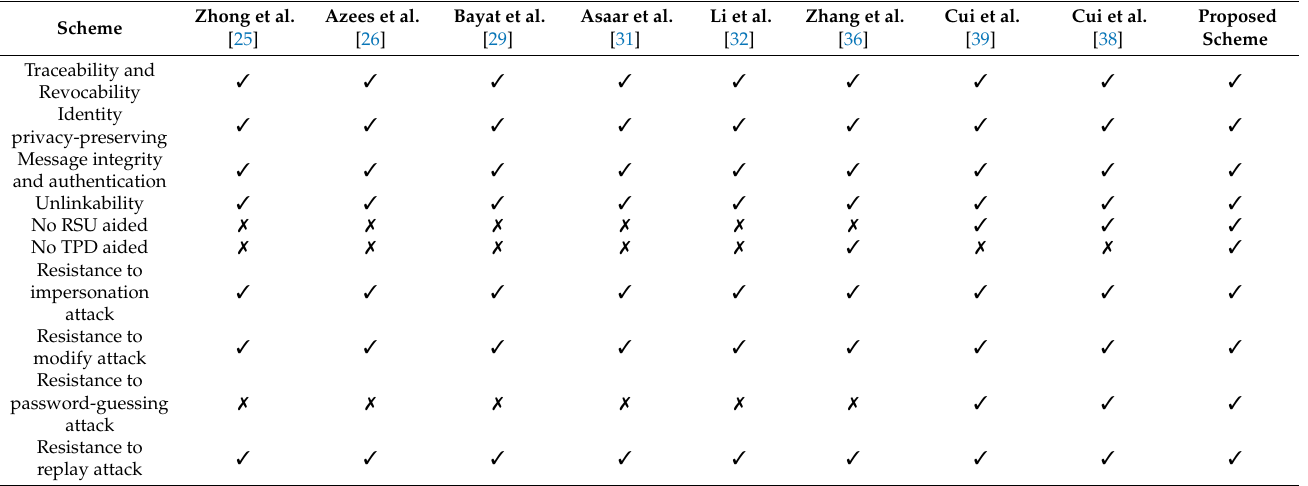
Table 2. Security comparison.